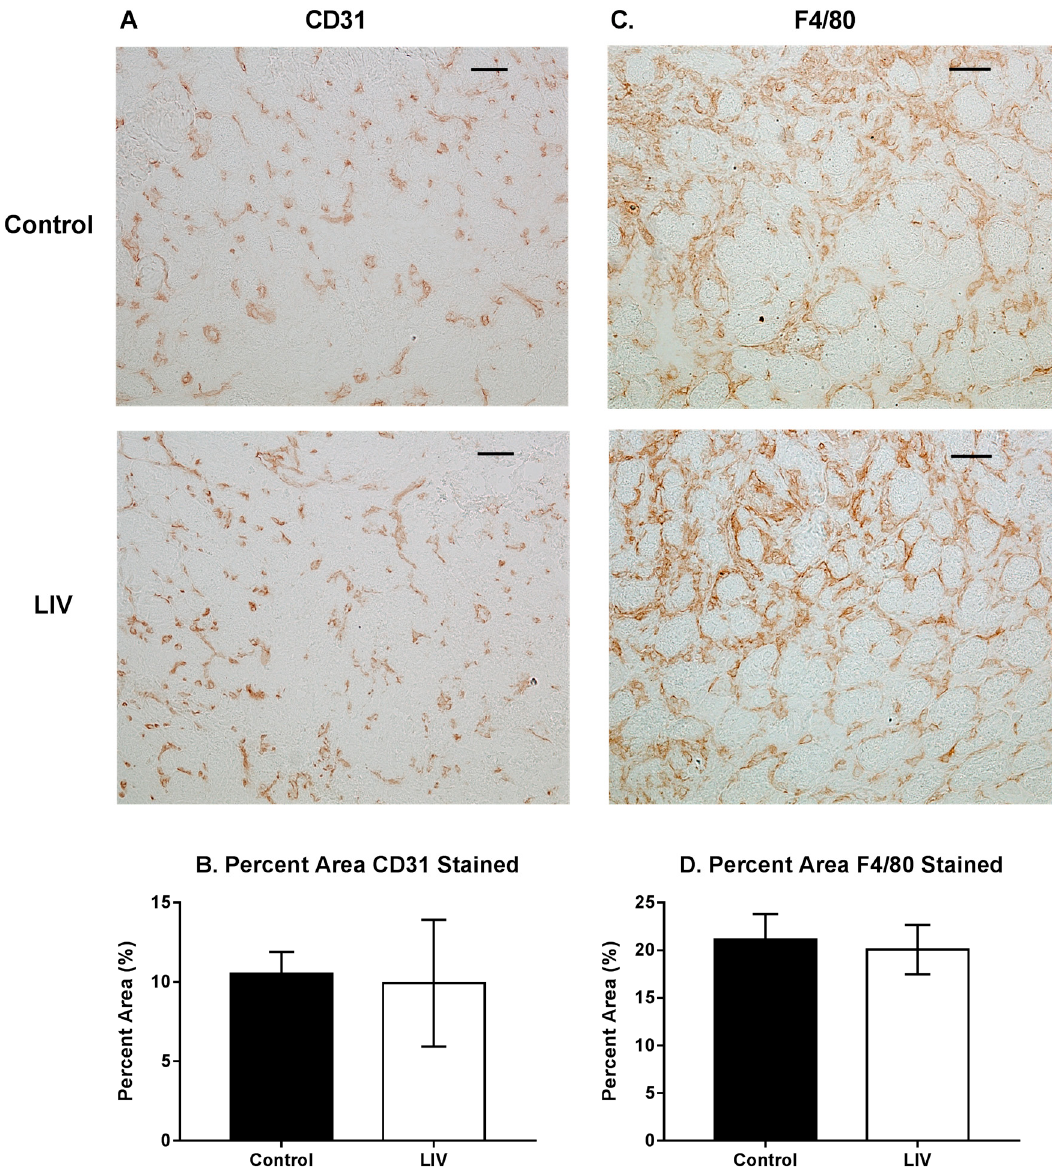
Figure 6. Effects of low-intensity vibration (LIV) at 90 Hz and 0.2 g on angiogenesis (CD31) and macrophage accumulation (F4/80) at day seven post-injury following laceration muscle injury in mice. Gastrocnemius muscles were lacerated and collected for histological analysis at day seven post-injury. ( A ) Representative images of CD31-stained sections (scale bar = 50 µ m, 20 × magnification); ( B ) Percent area that stained positive for CD31; ( C ) Representative images of F4/80-stained sections (scale bar = 50 µ m, 20 × magnification); ( D ) Percent area that stained positive for F4/80. Data are presented as mean ± SE. n = 6 per group.